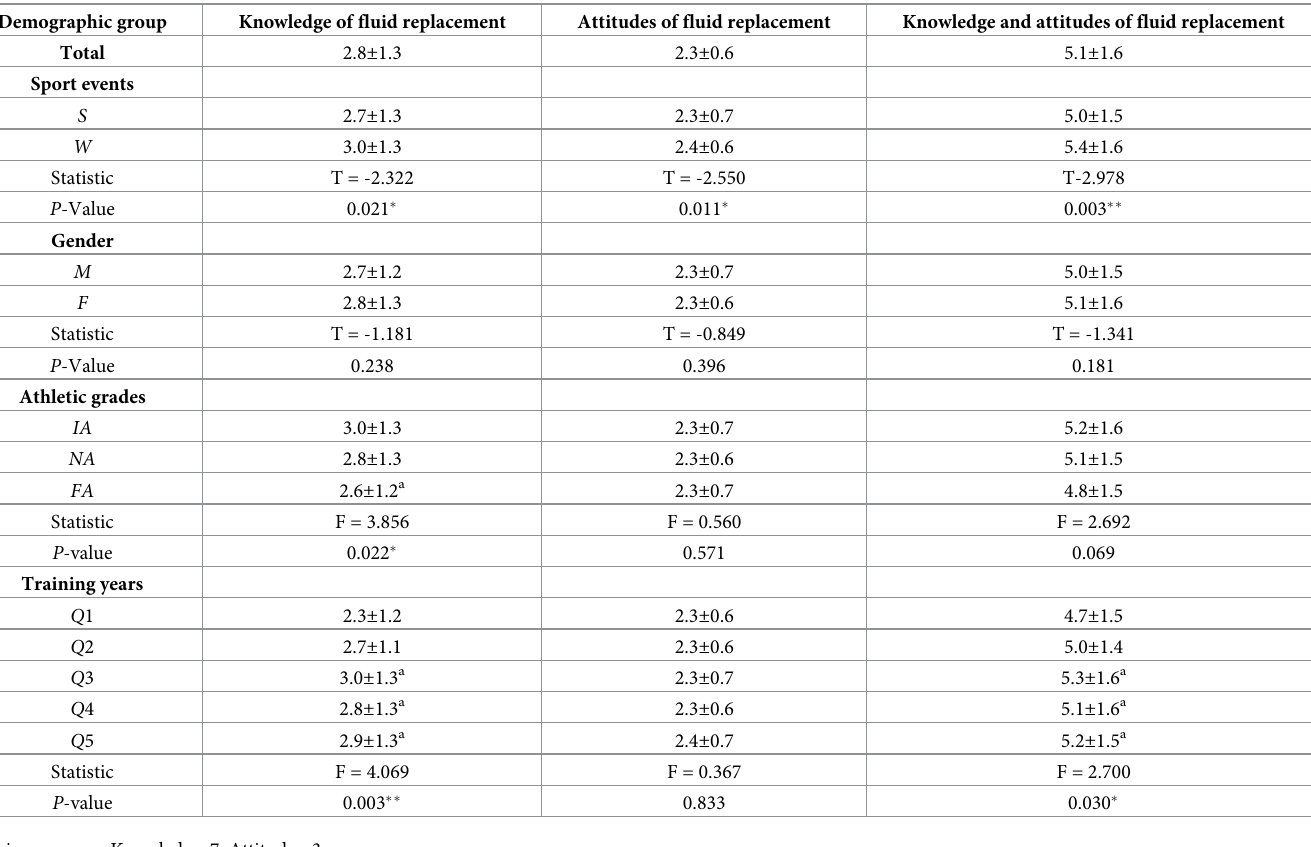
Table 2. Mean scores of knowledge and attitude of fluid replacement (Mean ±